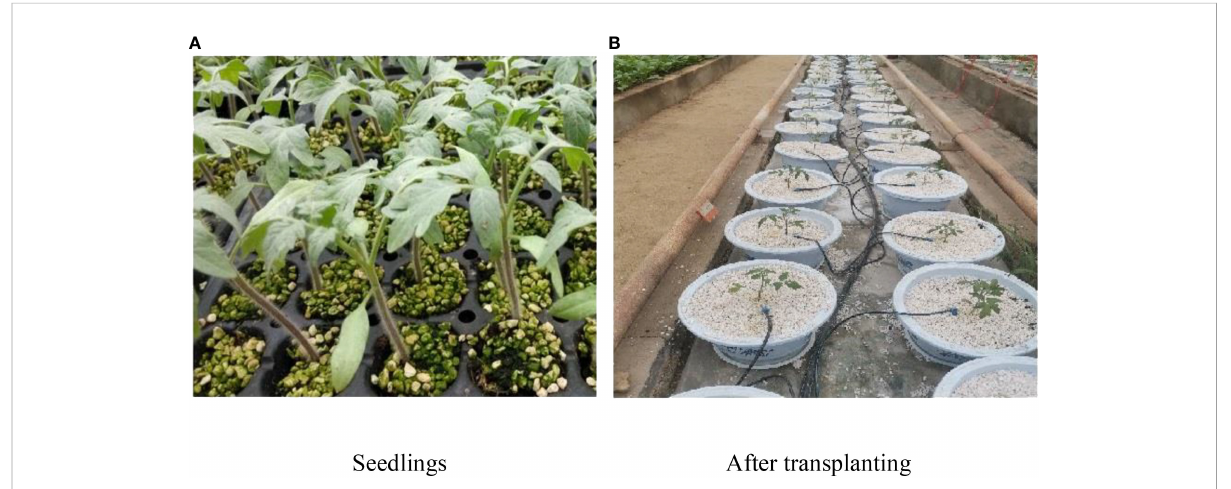
FIGURE 1 The sample cultivation. (A) Before smoothing (B) After